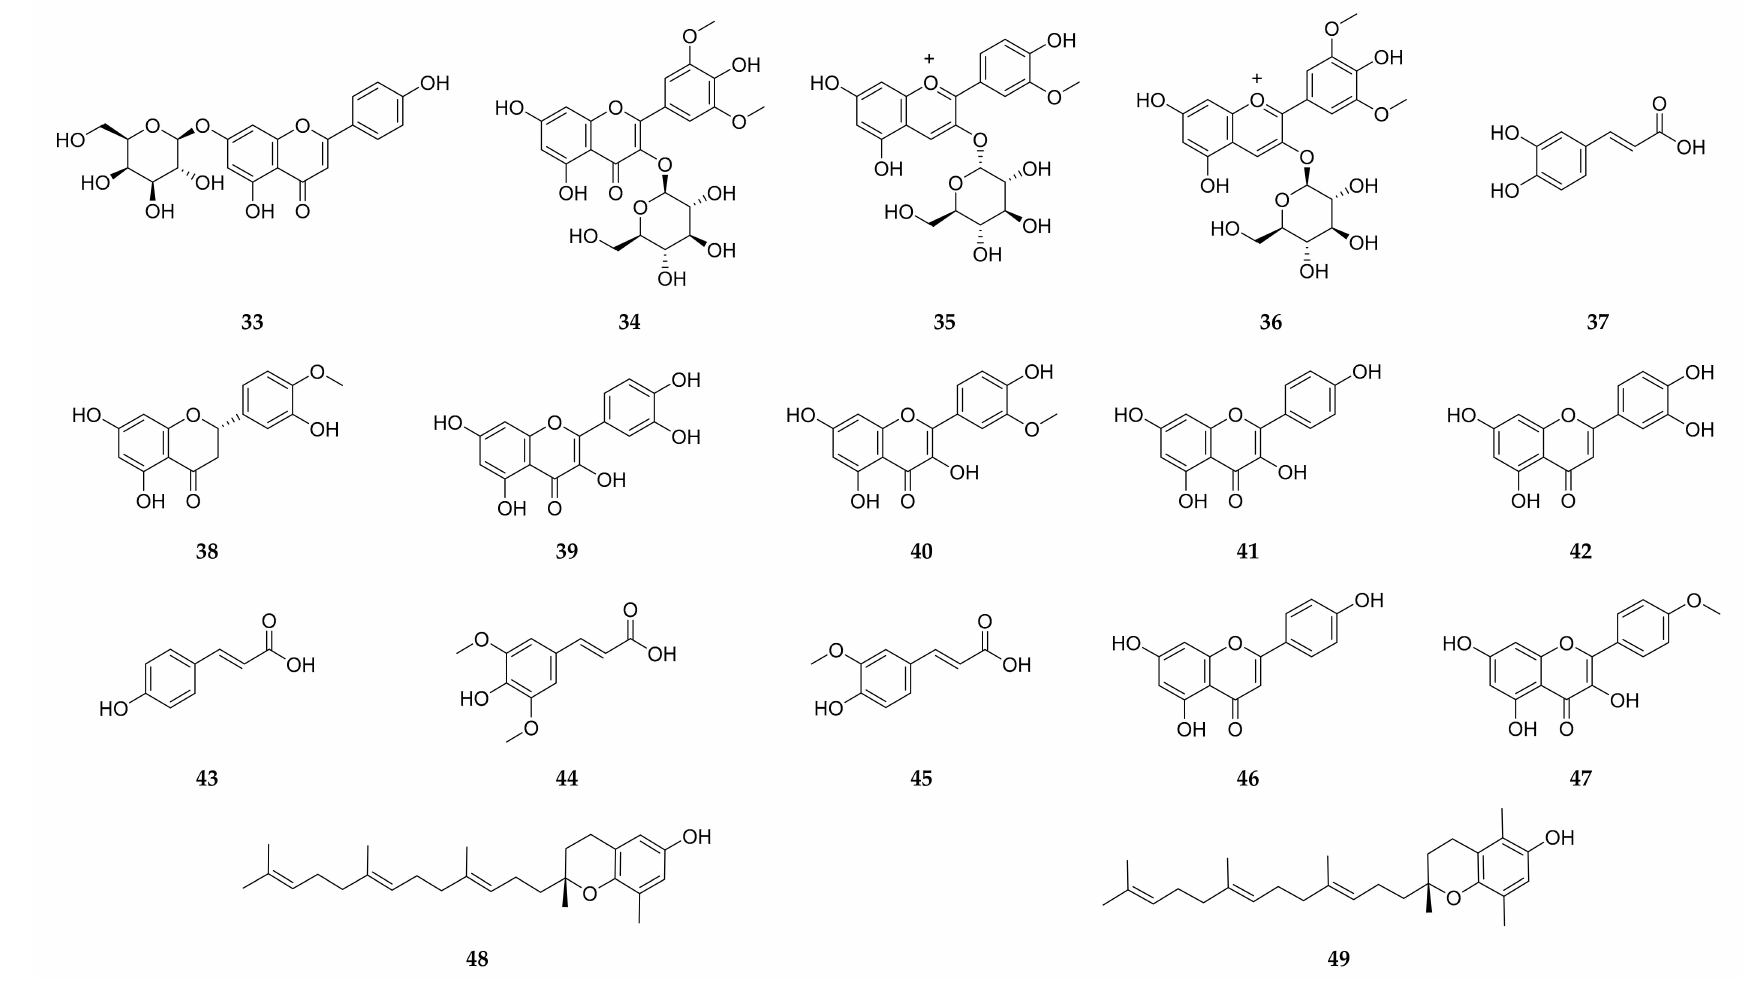
Figure 4. Chemical structures of the identified compounds by LC-ESI-TOF-MS /